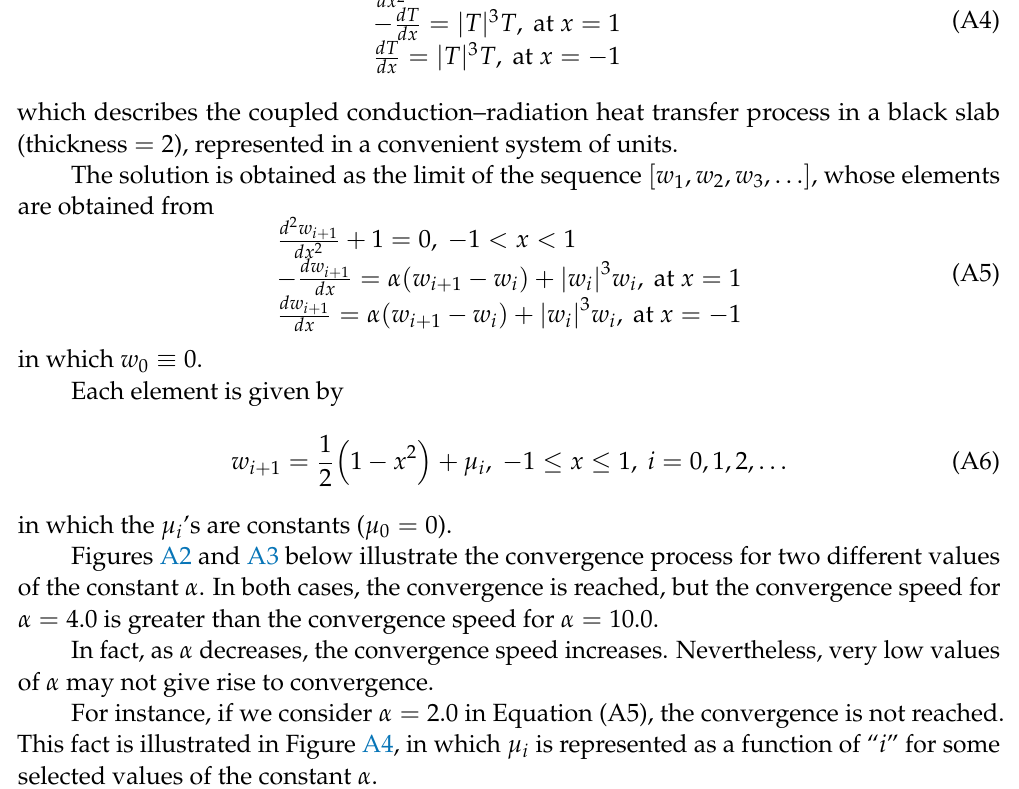
Figure A1. The temperature at the surface as a function of / qL h for three values of m .